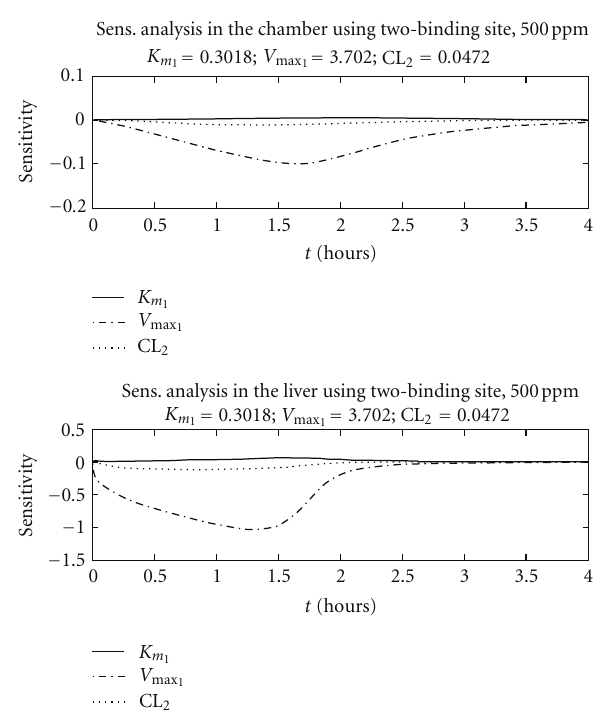
Figure 6: Sensitivity coe ffi cients for the two-binding site model at 500ppm. Each concentration includes the analysis using air and liver